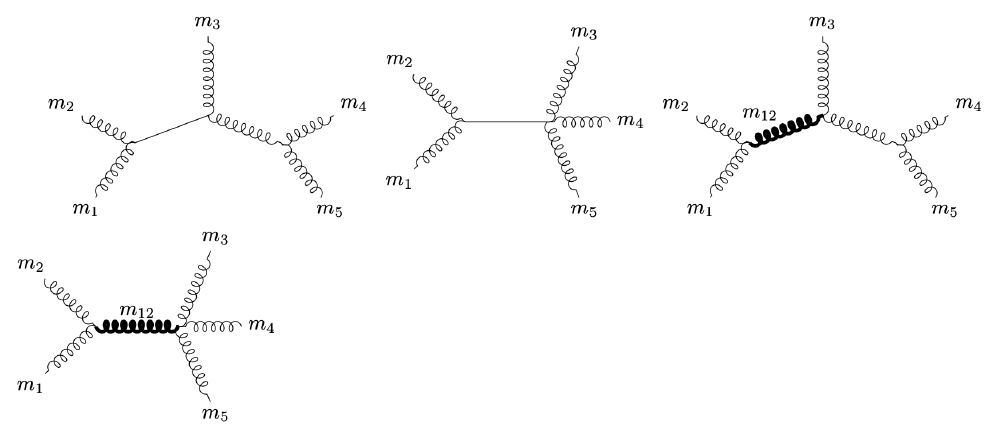
Figure 7 . Five point diagrams for the general case when m 1 + m 2 = 0 . The bold curly line represents a massless gluon, where m 12 = 0 and the straight line a massless scalar.